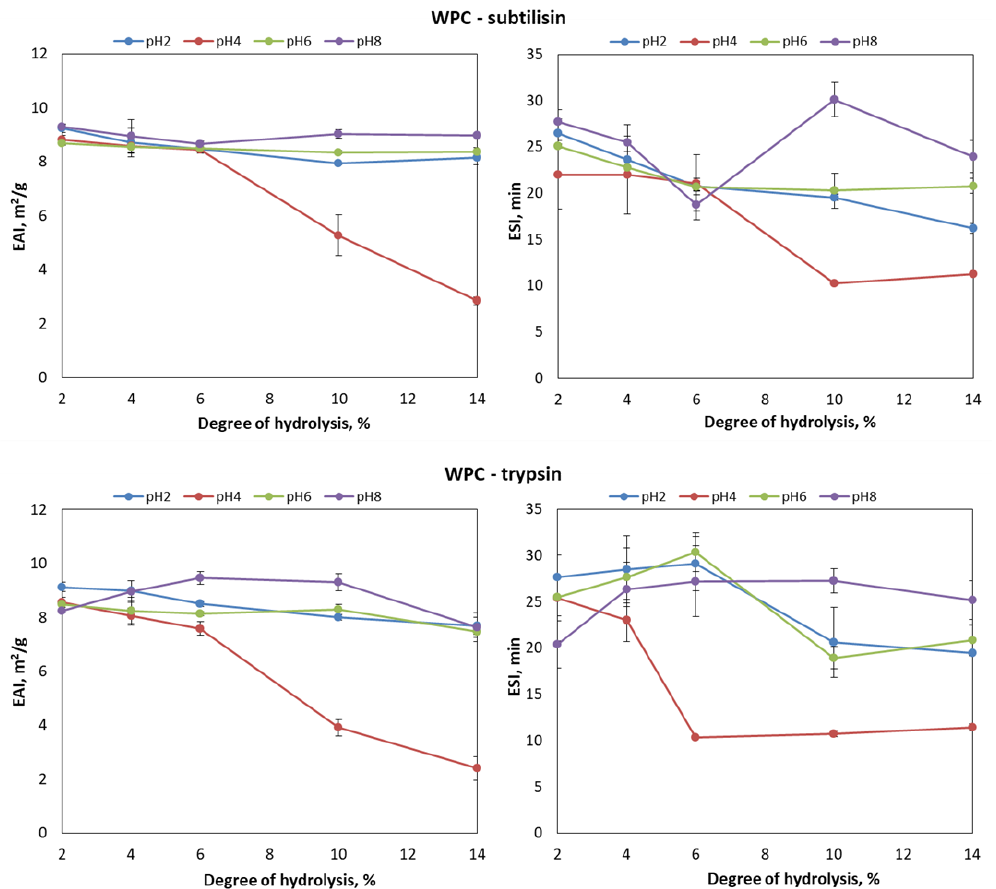
Figure 1. Emulsifying activity index (EAI, m 2 / g) and emulsifying stability index (ESI, min) against pH (2, 4, 6 and 8) and degree of hydrolysis (2%, 4%, 6%, 10% and 14%) for the whey protein concentrate (WPC) hydrolysates produced with subtilisin and